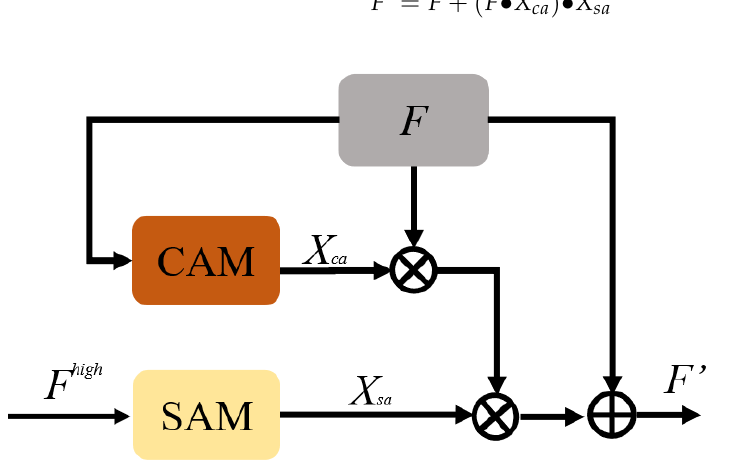
Figure 5. Architecture diagram of proposed repeated attention mechanism.